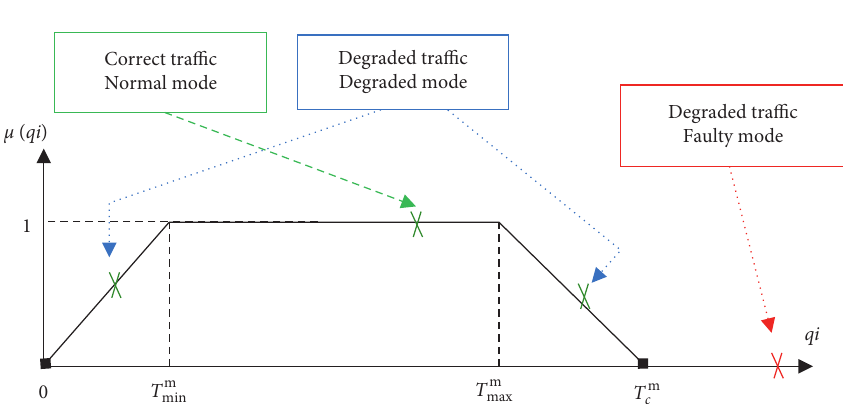
Figure 10: Function of possibility associated with an effective sojourn time ( q